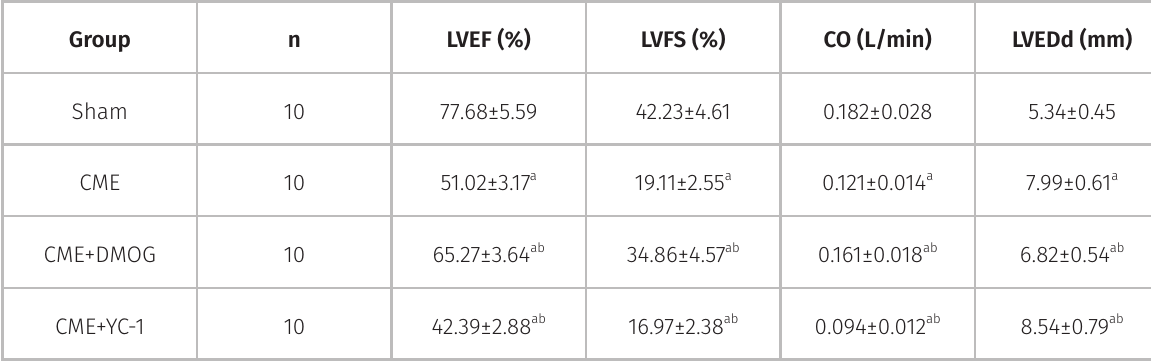
Table I. Changes in cardiac function ( x ± s ). Group n LVEF (%)